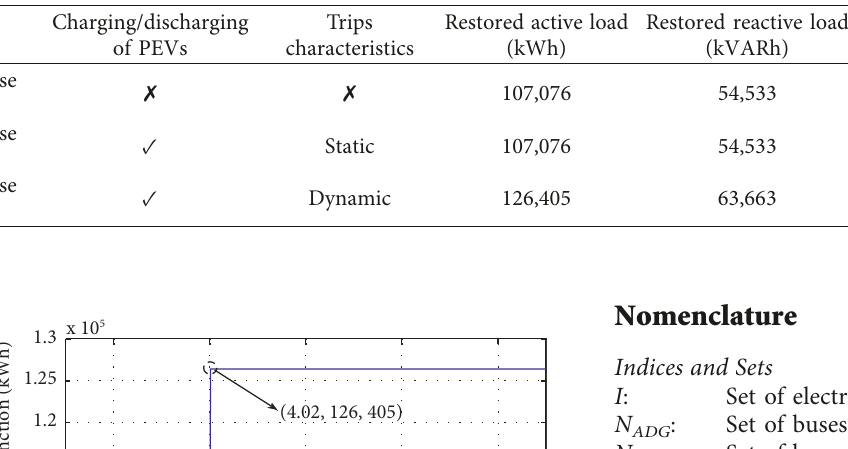
Table 8: Comparing the results for three different cases.